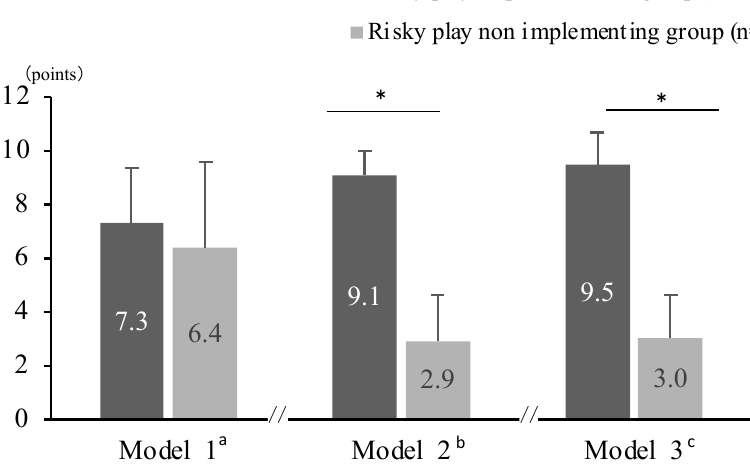
Figure 2. Prosocial scores by implementation of risky play. ( a ) Results of covariance analysis with